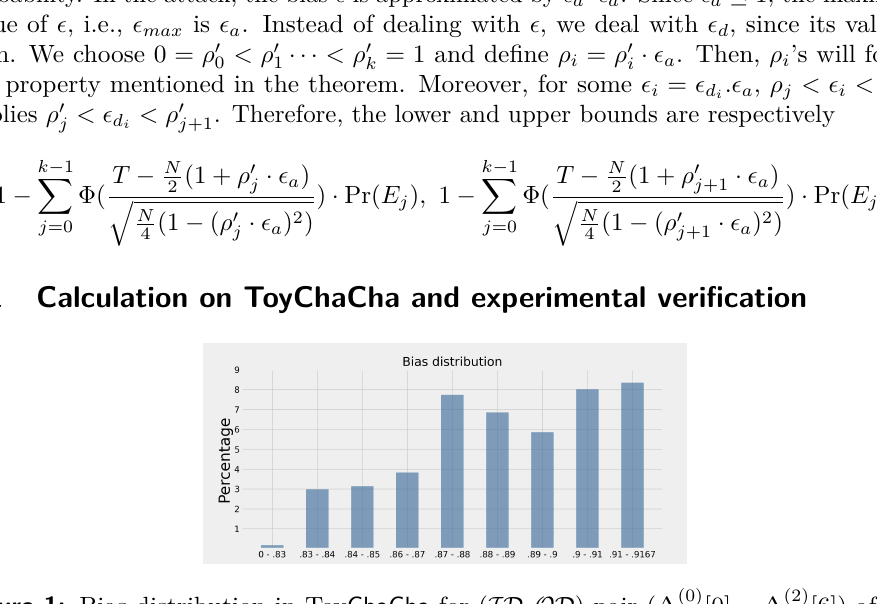
[0] − ∆ (2) [6]) after 2 13 1